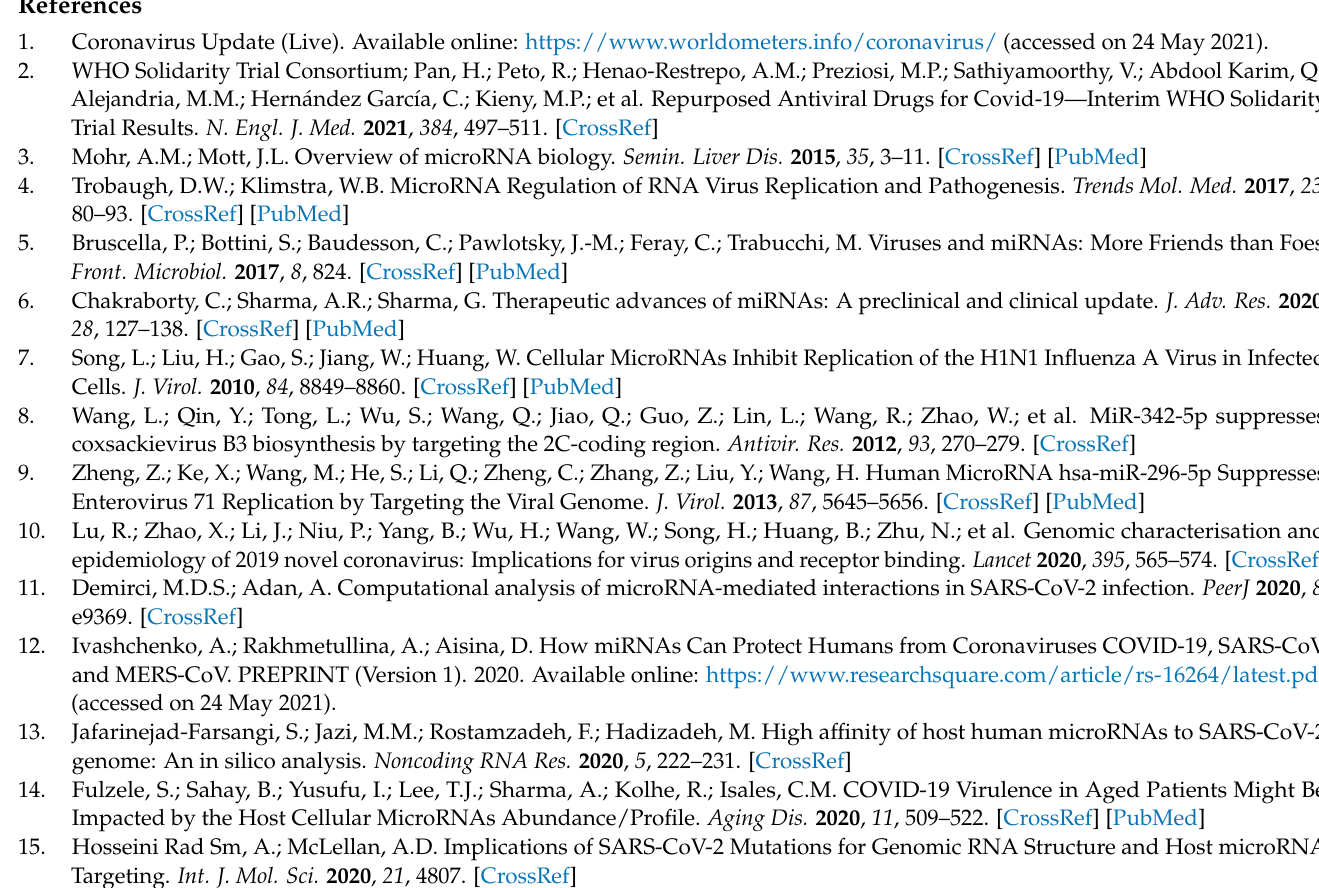
comparisons. Figure S1: Extended Figure 2, Figure 3, and Figure 4 detailing the individual values of all replicates in each